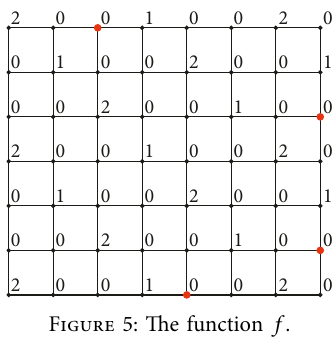
Figure 6: The function f ′ where r � 3 k + 1 , s � 3 l + 1 and r ≡ 1 mod6 .